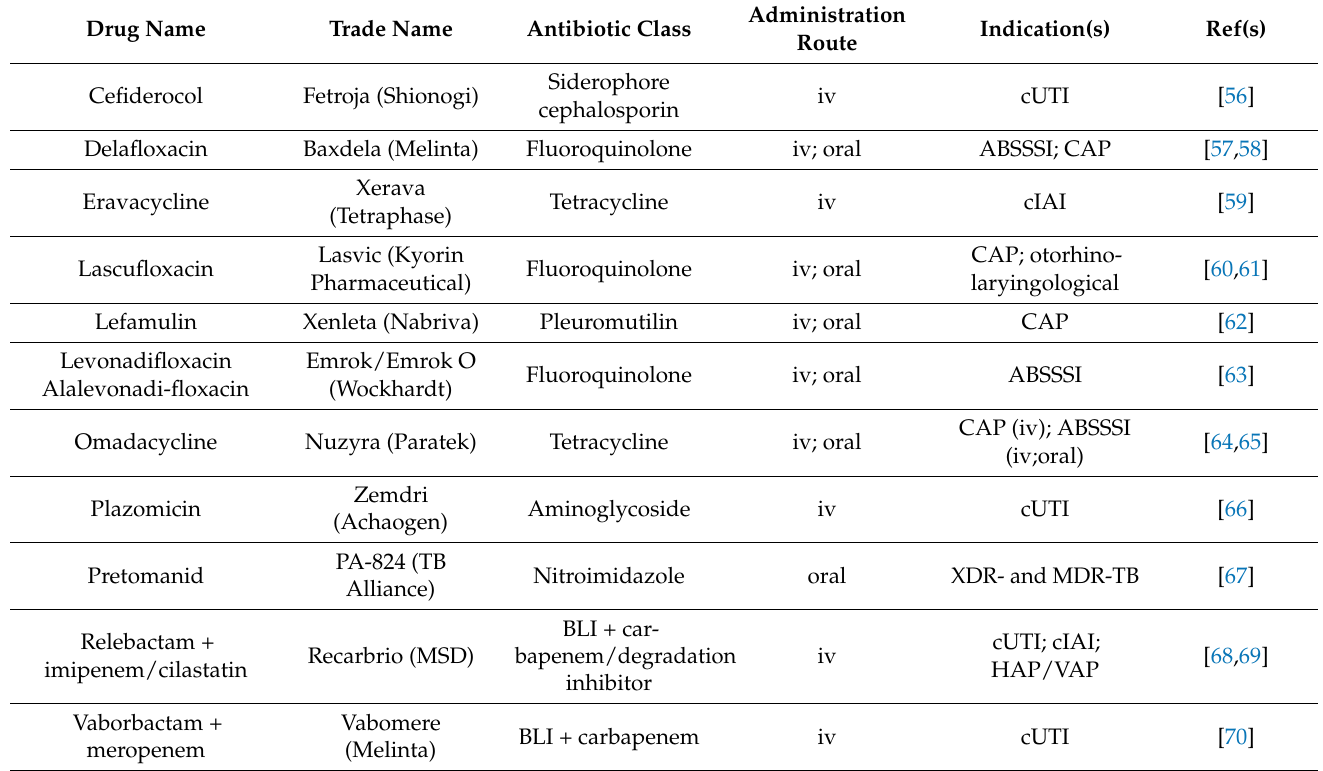
Table 1. Newly developed antimicrobials since